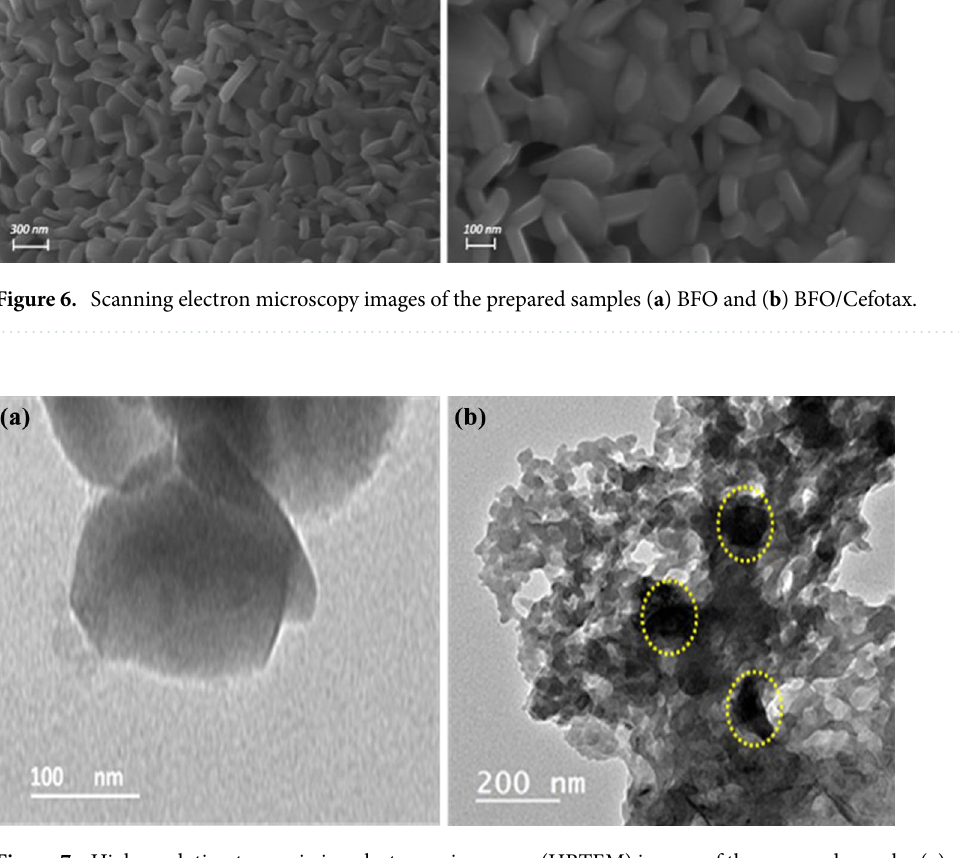
Figure 7. High resolution transmission electron microscopy (HRTEM) images of the prepared samples ( a ) BFO and ( b )